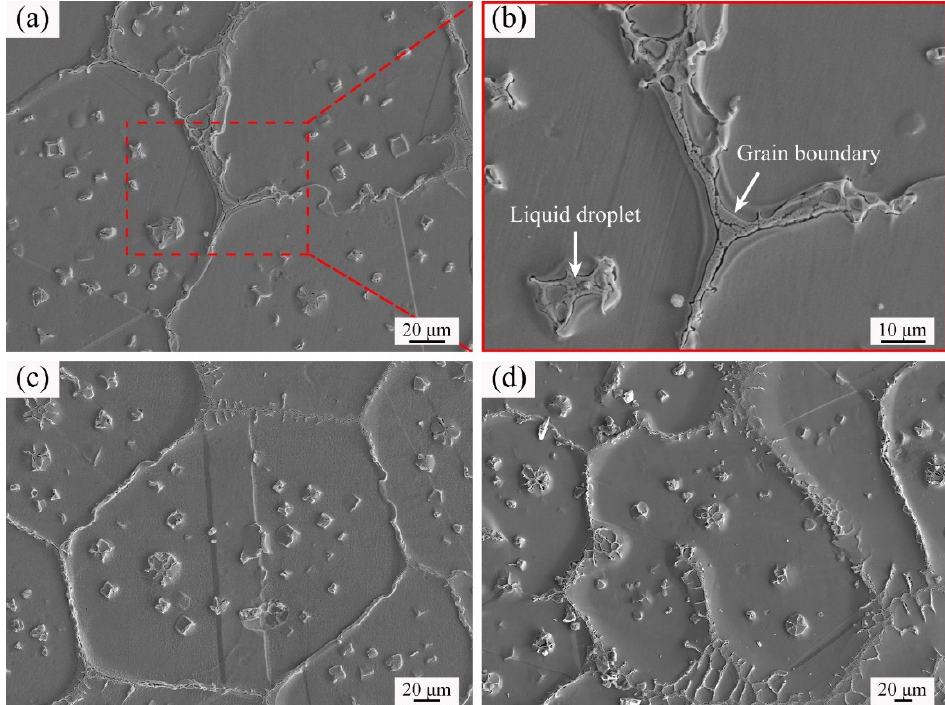
Figure 8. SEM images of GH3536 alloy after soaked for 60 min at various temperatures: ( a ) 1350 °C, ( b ) the enlarged image of ( a ), ( c ) 1364 °C, and ( d ) 1367 °C. Figure 9 is the SEM image of GH3536 billet soaked at 1360 °C for 120 min. The precip- itates occurred on the grain boundaries (Location 1) and in the liquid drops (Location 2).